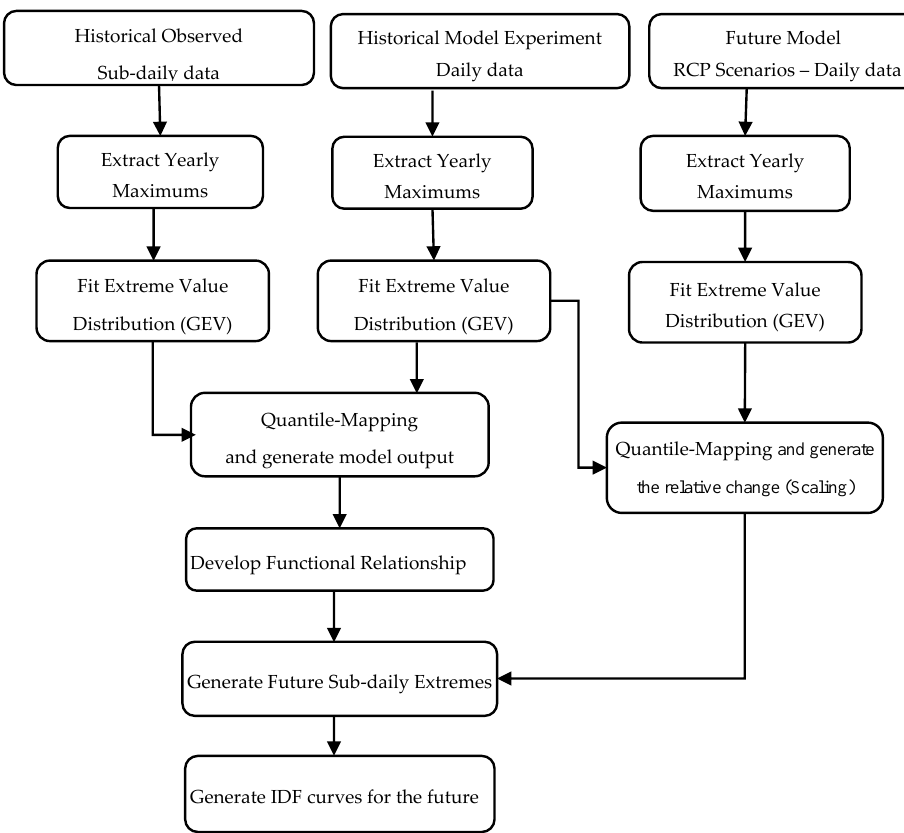
Figure 1. Equidistance Quantile-Matching method for generating future Intensity–Duration–Frequency (IDF) curves under climate change.